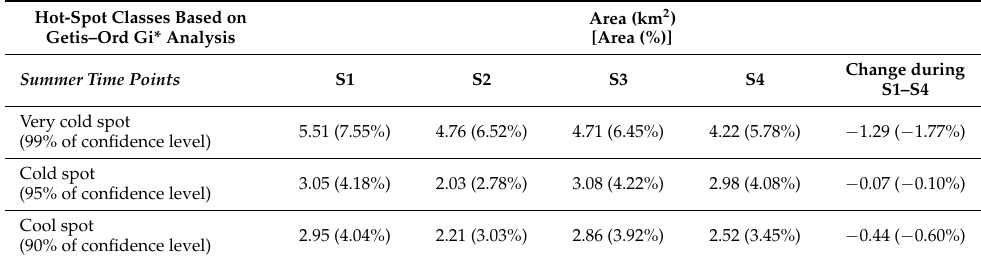
Figure 18. Seasonal hotspot maps based on Getis–Ord G i * in Prayagraj city (1987–2018): ( a ) summer and ( b ) winter. Table 8. Seasonal hotspot classes based on Getis–Ord G i * statistics.